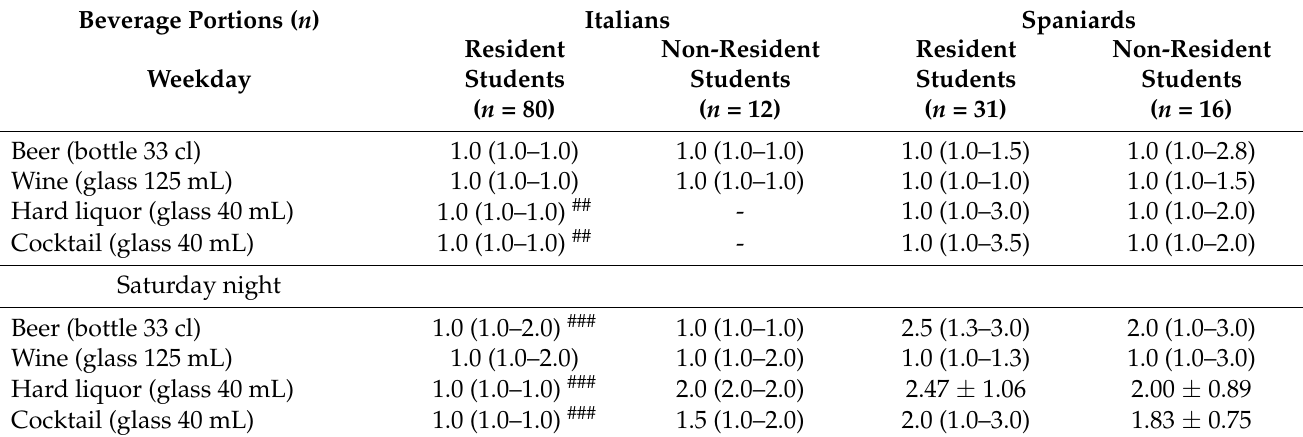
Table 3. Alcohol consumption in resident and non-resident students.